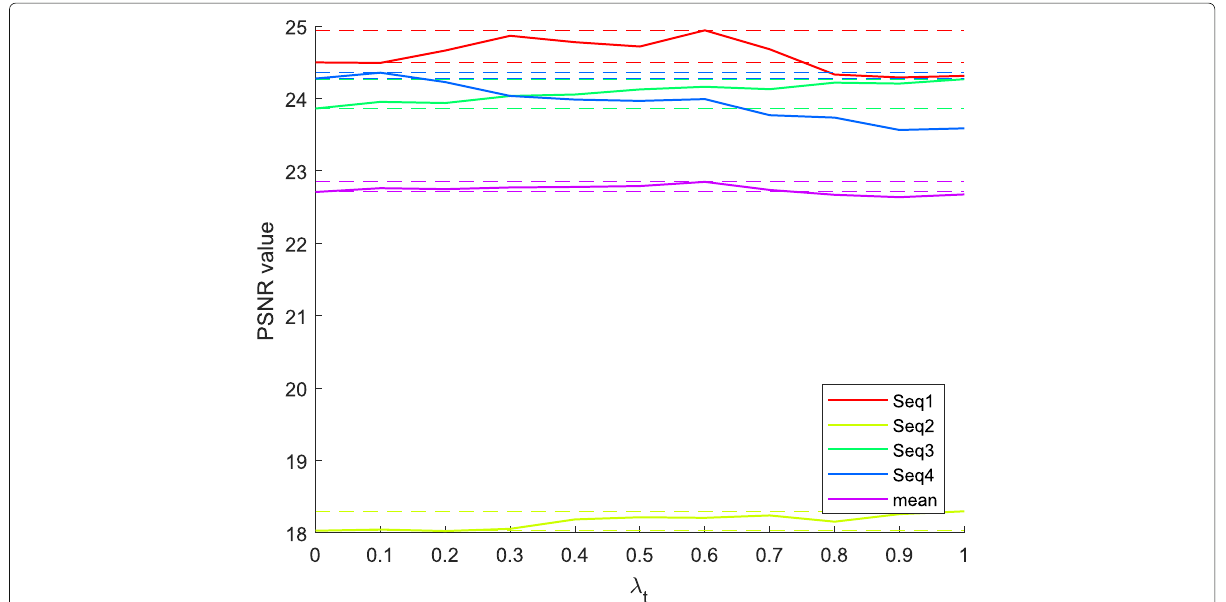
Fig. 7 PSNR vs λ t . The above plot shows PSNR value as a function of λ t . The lower line shows the performance of the proposed method without texture, and the upper line shows the maximum improvement with texture features for a given sequence. We can see that the texture component improves the interpolated frame quality depending on the complexity of the